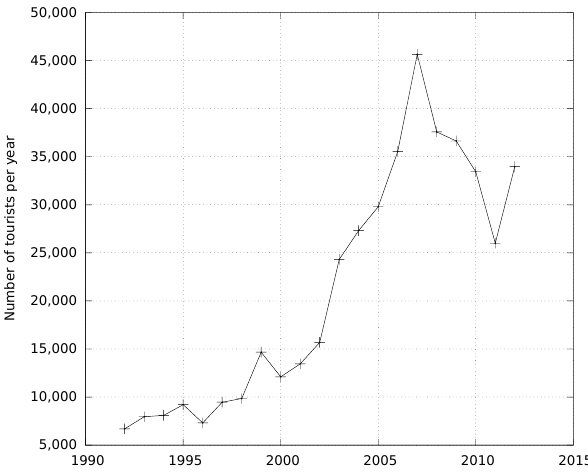
Figure 1. Number of tourists visiting the Antarctic by ship (IAATO, 2013).